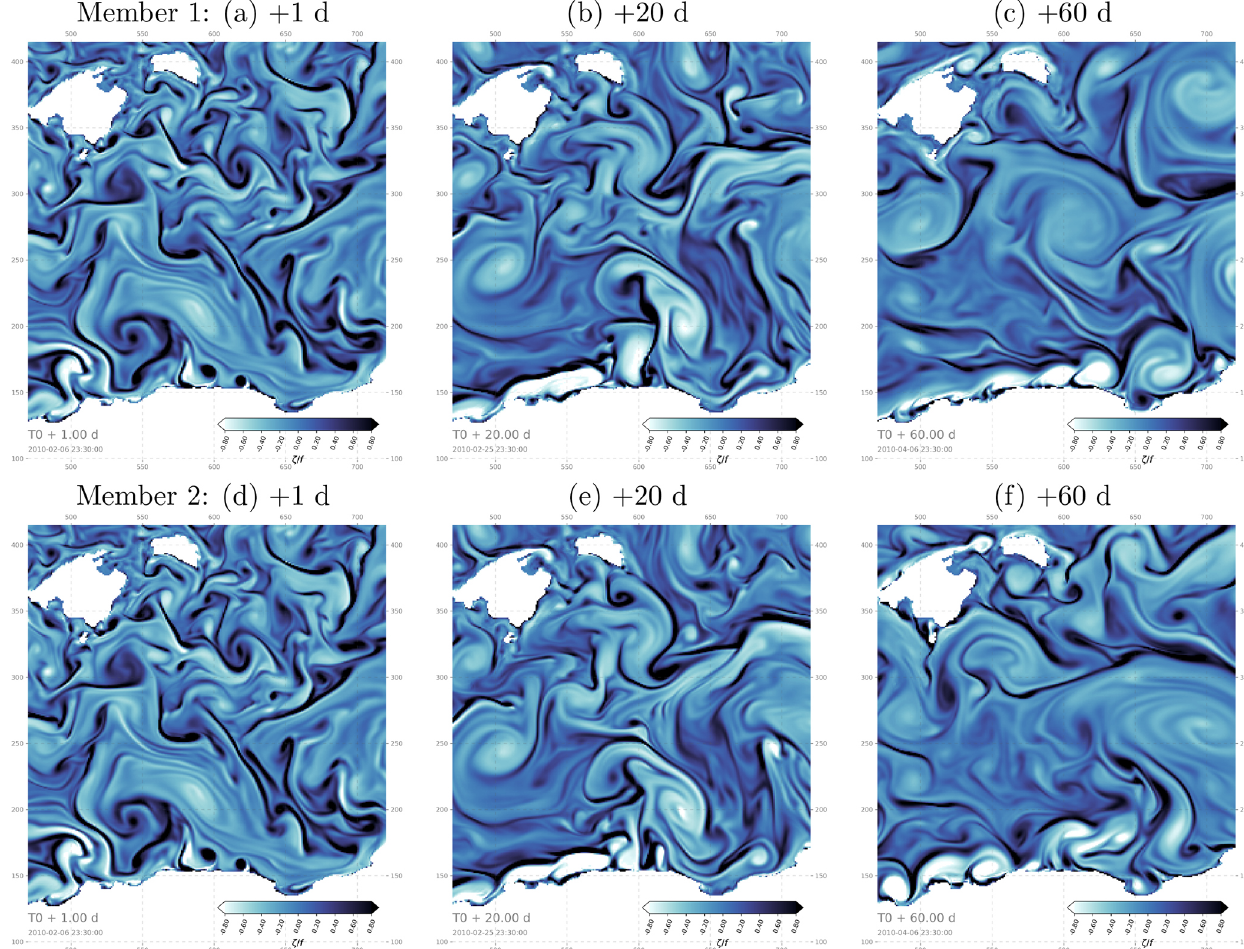
Figure 6. Hourly snapshots of relative vorticity from two example members (top and bottom, respectively) after 1, 20 and 60d (from left to right, respectively) in the ensemble experiment ENS-CI, focusing on a 250 × 250 grid point subregion southeast of the Balearic Islands (box b in Fig.